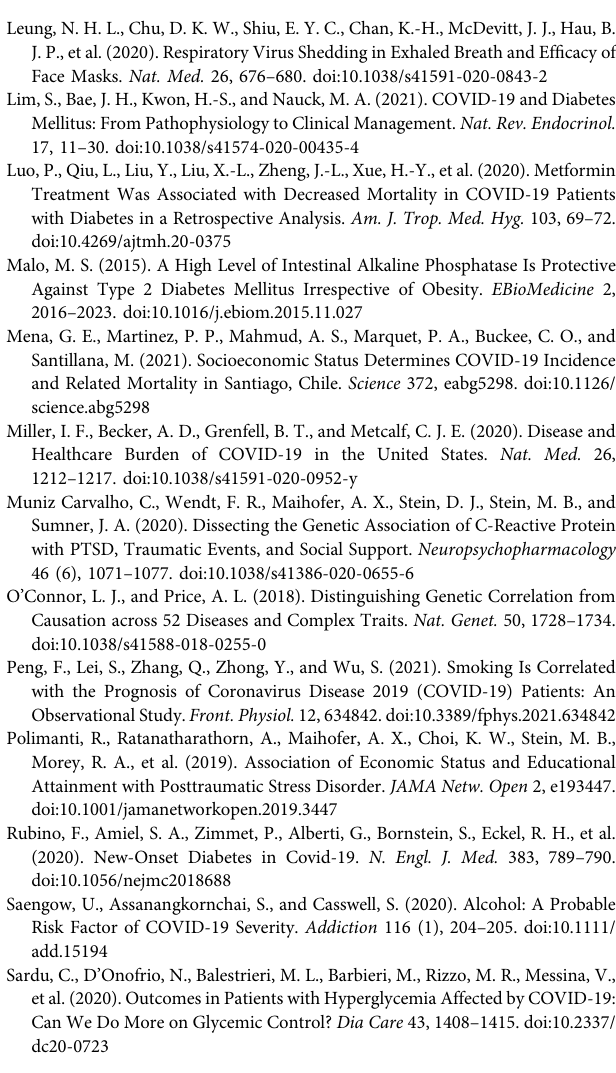
Supplementary Figure S1 | Heterogeneous effects of rs143334143 on lymphocyte count and rs45524632 on heel bone T-score across six world populations from the Pan-UK Biobank. Double asterisks indicate signi fi cance after multiple testing correction (FDR 5%) while single asterisks indicate nominal